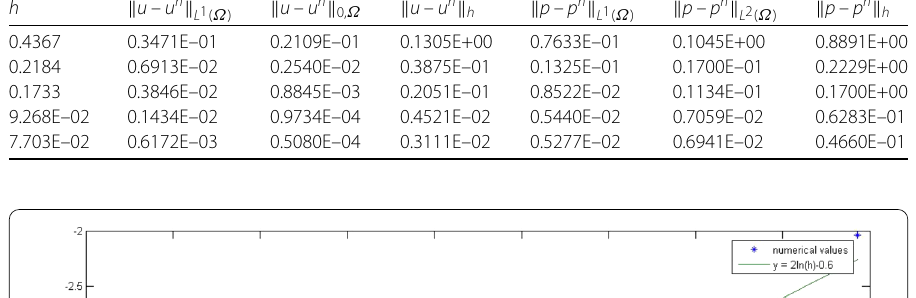
Table 1 Table of errors in the L 2 ( Ω ) and energy norms h